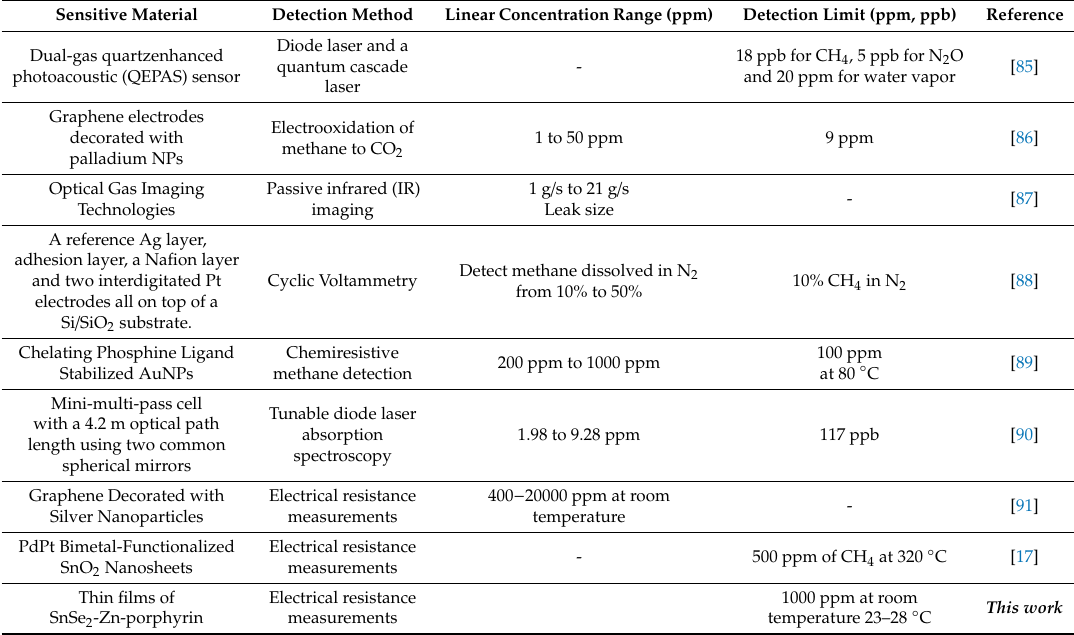
Table 1. Detection limits and linear concentration range of recently developed sensors for the determination of methane, using di ff erent sensitive materials and